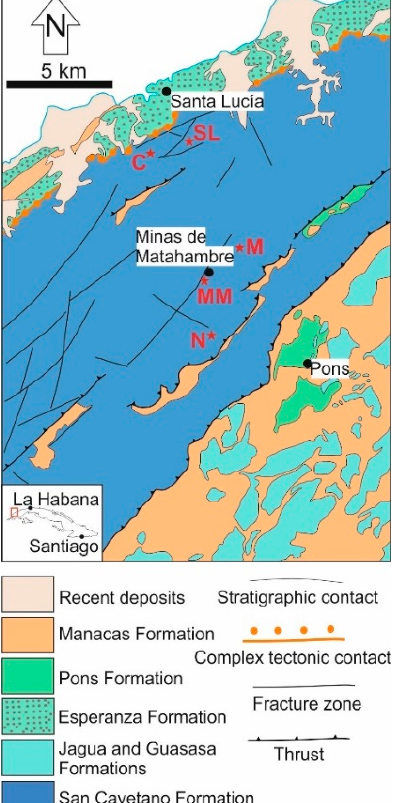
Figure 1. Geological map of the north-west (NW) zone of the Sierra de Los Órganos in NW Cuba, Figure 1. Stratigraphic sequence of the Guaniguanico Terrane at the Sierra de Los Ó rganos ( left ) showing the location of the most important mineral deposits: C: Castellanos, SL: Santa Lucía, MM: with a detailed description of a section of the San Cayetano formation from Minas de Matahambre to Minas de Matahambre, N: Nieves and M: Mella. Modified from [16]. Santa Luc í a ( right ) (see location in Figure 2). The stratigraphic location of the most important ore deposits in the region are indicated in the San Cayetano